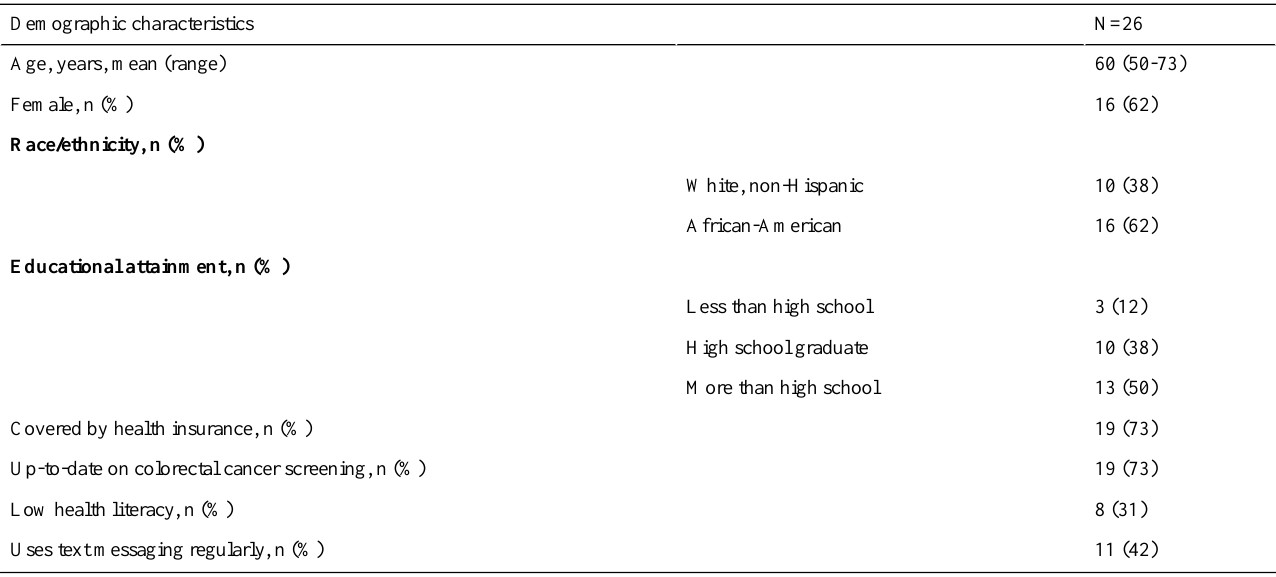
Table 1. Characteristics of focus group